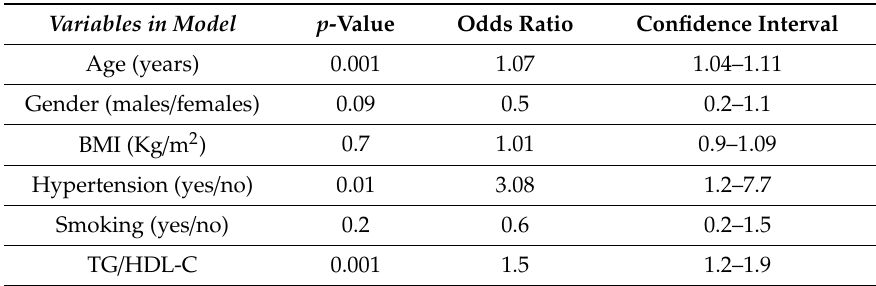
Table 4. Logistic regression analysis for the prediction of eGFR < 60 mL / min / 1.73 m 2 . Variables in Model p -Value Odds Ratio Confidence Interval Age (years) 0.001